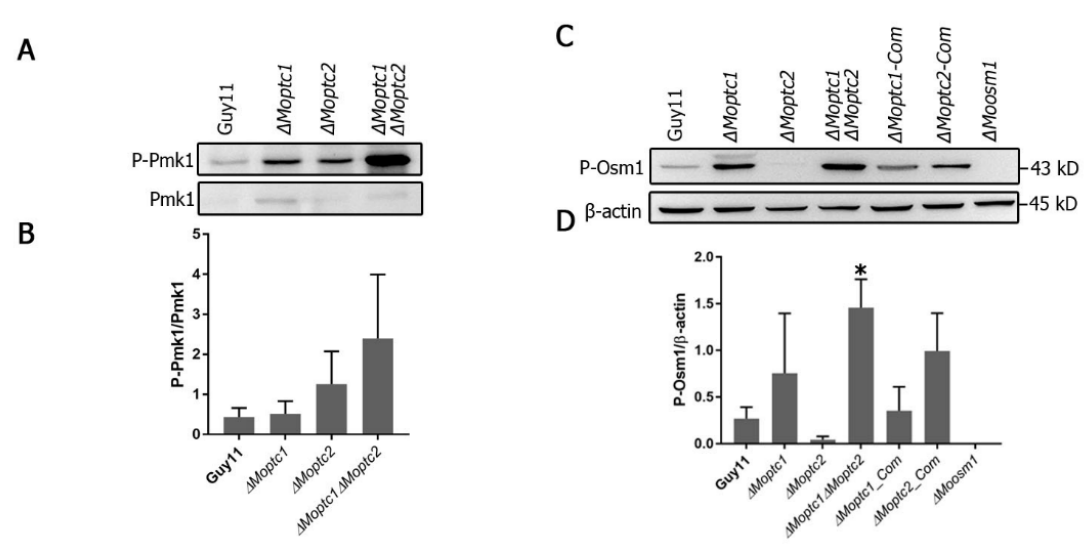
Figure 2. MoPtc1 and MoPtc2 regulate MAPK signaling cascades in M. oryzae . ( A ) The Western blot assay shows the Pmk1 phosphorylation level in Guy11, ∆ Moptc1 , and ∆ Moptc2 and ∆ Moptc1 ∆ Moptc2 strains. ( B ) The extent of Pmk1 phosphorylation was estimated by calculating the amount of phosphorylated Pmk1 (P-Pmk1) compared to the total amount of Pmk1. ( C ) Western blot images quantify the Osm1-MAPK phosphorylation in Guy11 and ∆ Mopt c1, ∆ Moptc2 , ∆ Moptc1 ∆ Moptc2 , ∆ Moptc1_Com (Complementation), ∆ Moptc2_Com (Complementation), and ∆ Moosm1 . ( D ) The band intensity ratio between phosphorylated Osm1 (P-Osm1) and β -actin. The single asterisk (*) represents statistical significance with an adjusted p -value of 0.0338.